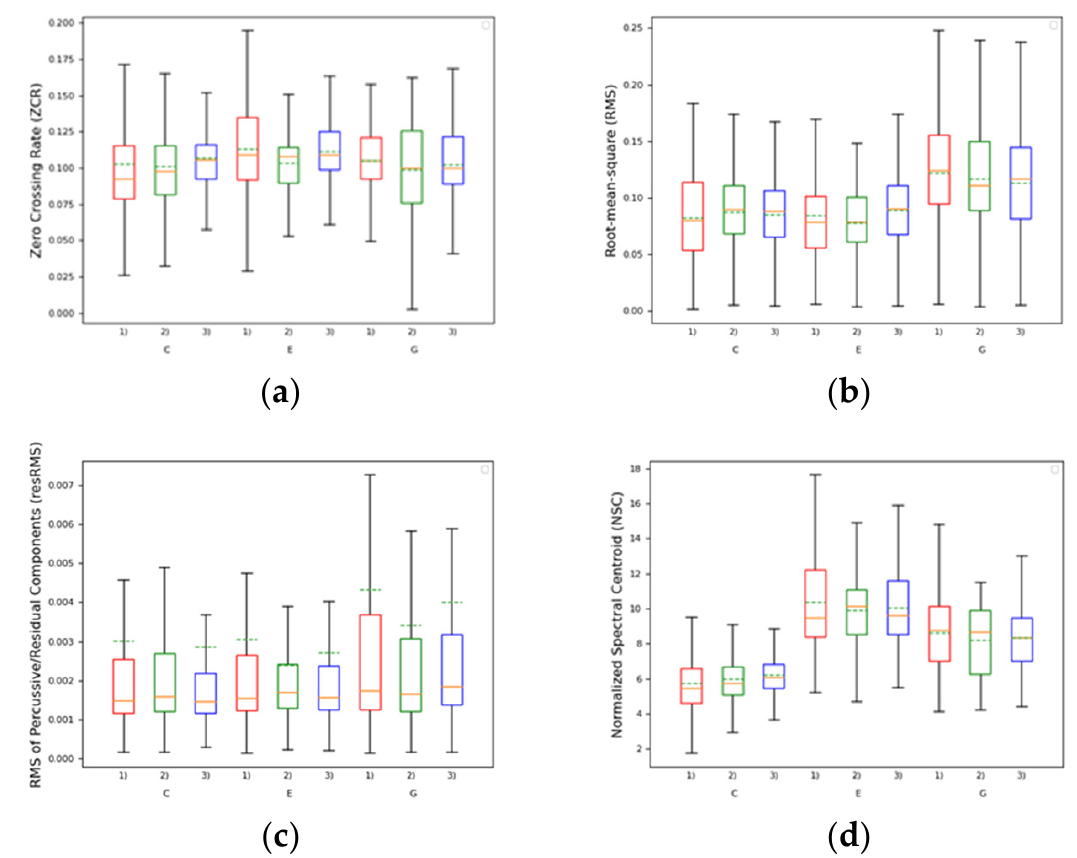
Figure 8. Box plots of global statistics per register and intra-oral appliances for ( a ) ZCR; ( b ) RMS; ( c ) resRMS; and ( d ) NSC. Numbers in the x-axis denote intra-oral appliances: (1) HACI, (2) TEATA, and (3) Customized Splint. Low, mid, and high registers are expressed by the performed note (i.e., C, E, and G, respectively). Orange and dashed green lines denote median and mean values, respectively.